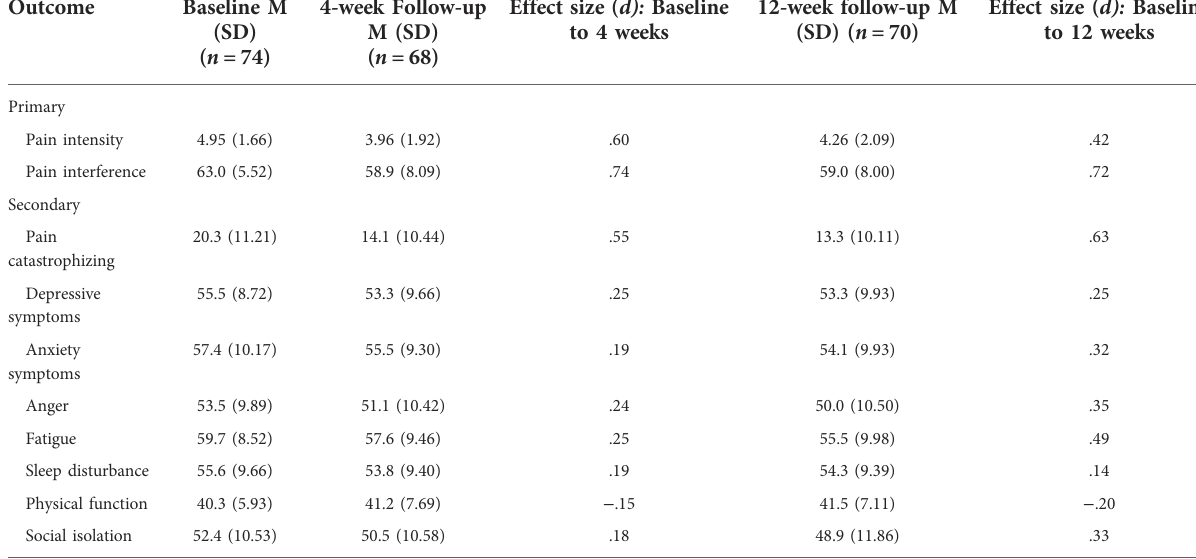
TABLE 3 Primary and secondary outcomes at baseline and primary and secondary endpoints (4- and 12-week follow-ups). Outcome